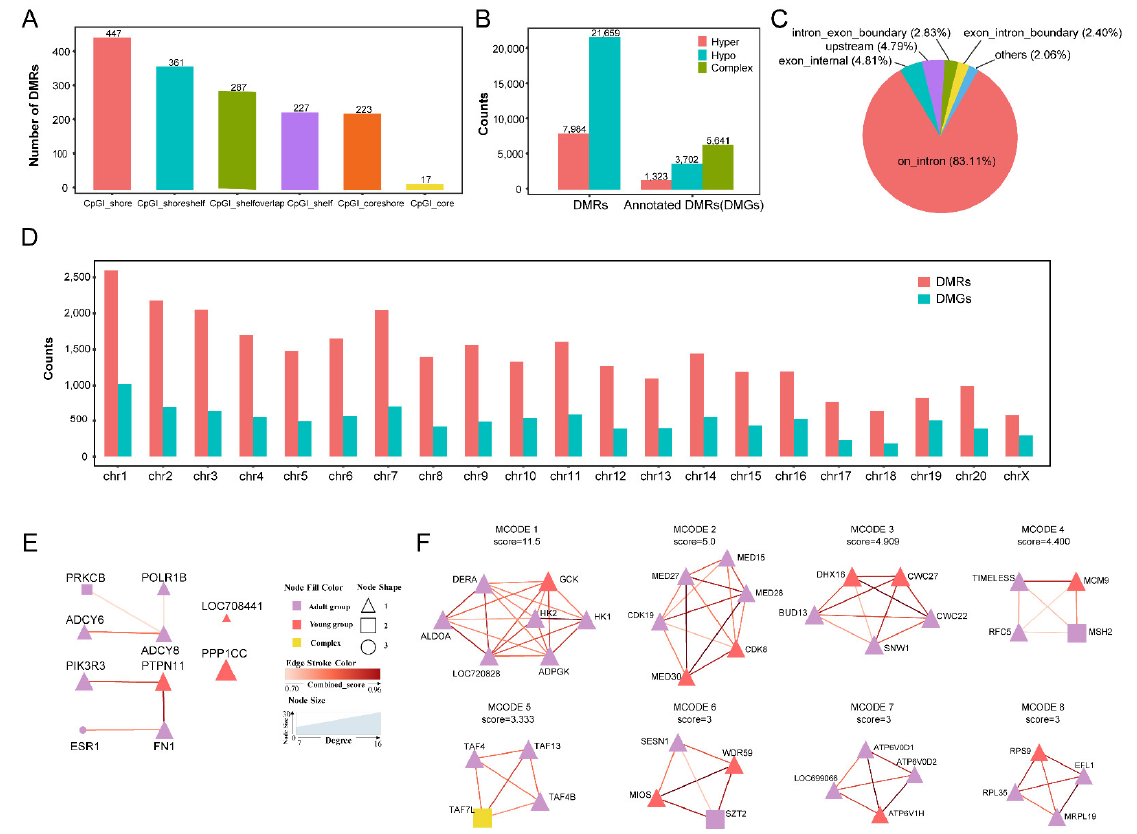
Figure 2. Differentially methylated regions in the adult group compared with the young group. ( A ) A total of 1562 differentially methylated regions (DMRs) (5.27% of 29,642 DMRs) were annotated to the CpG island location. ( B ) The number of hypercomplex DMRs and annotated DMRs (DMGs). ( C ) Pie chart showing the location of DMRs in the genome. A total of 28,607 DMRs (96.50%) were annotated to the gene location. ( D ) A total of 28,607 DMRs annotated to 10,666 DMGs were distributed on the chromosomes. The number of DMRs was highly correlated with the number of DMGs (R = 0.9160558, p -value = 5.6 × 10 −9 , Pearson’s product-moment correlation, 95 percent confidence interval = [0.8012, 0.9658]). ( E ) The network of ten hub genes with 12 algorithms using the cytoHubba plugin of Cytoscape v3.7.1. The color of each node represents the change in the DMR methylated level in the adult group compared with the young group (red, upregulated; purple, downregulated; and yellow, complex). The color gradation of the edge stroke is representative of the combined sore between the two genes. The node size represents the degree level of the hub genes. The node shape represents how many DMG had DMRs (triangle, only one; square, two; and circle, three). ( F ) The networks of the top eight MCODE models with a multi-protein complexes clustering algorithm using the Molecular Complex Detection (MCODE) plugin of Cytoscape v3.7.1. The color gradation of the node is representative of the log 2 fold change. The color of the edge stroke represents the combined sore between two genes. The node size has no meaning.